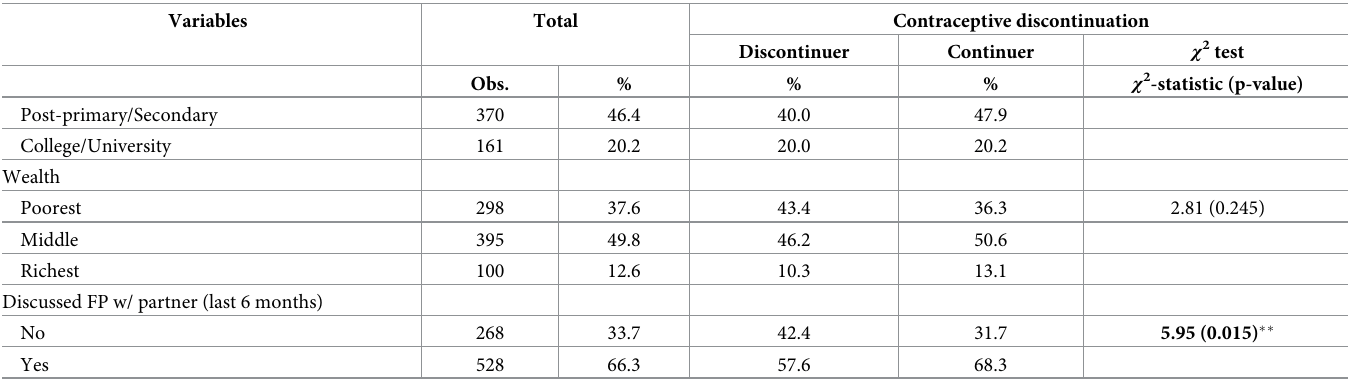
2.3.3. Probit regression models. We constructed a univariate probit model (Table 3)